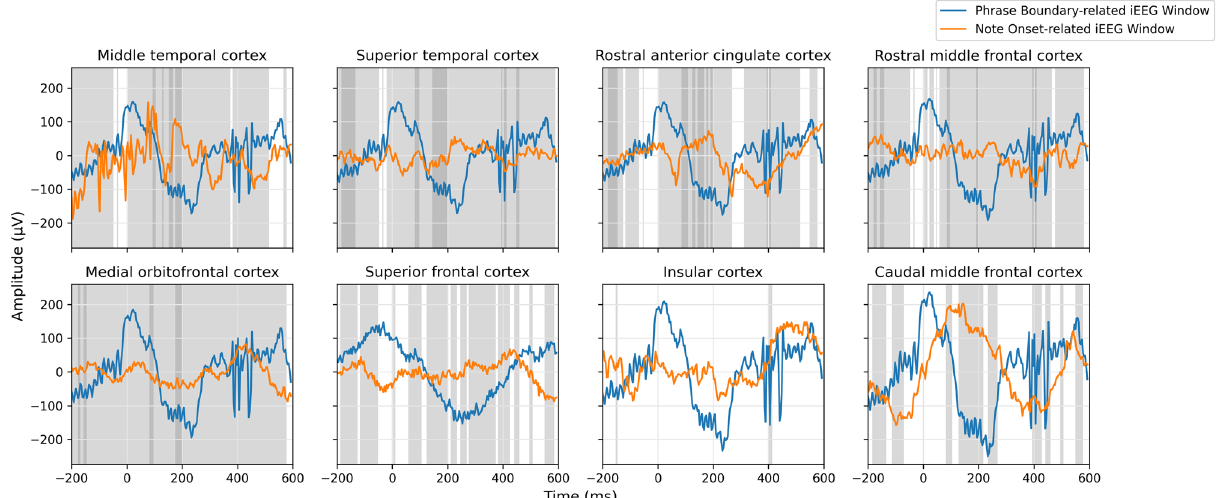
Figure 8. Note-Onset-related and Phrase-Boundary-related ERPs observed at these subregions with significant differences in at least six sessions are shaded in light gray, and ten sessions in dark gray respectively. Despite all note-onset-related iEEG windows being used in the analysis, eight windows were randomly sampled for display due to the large difference between the number of windows sampled around note onset and phrase boundaries and data variance.